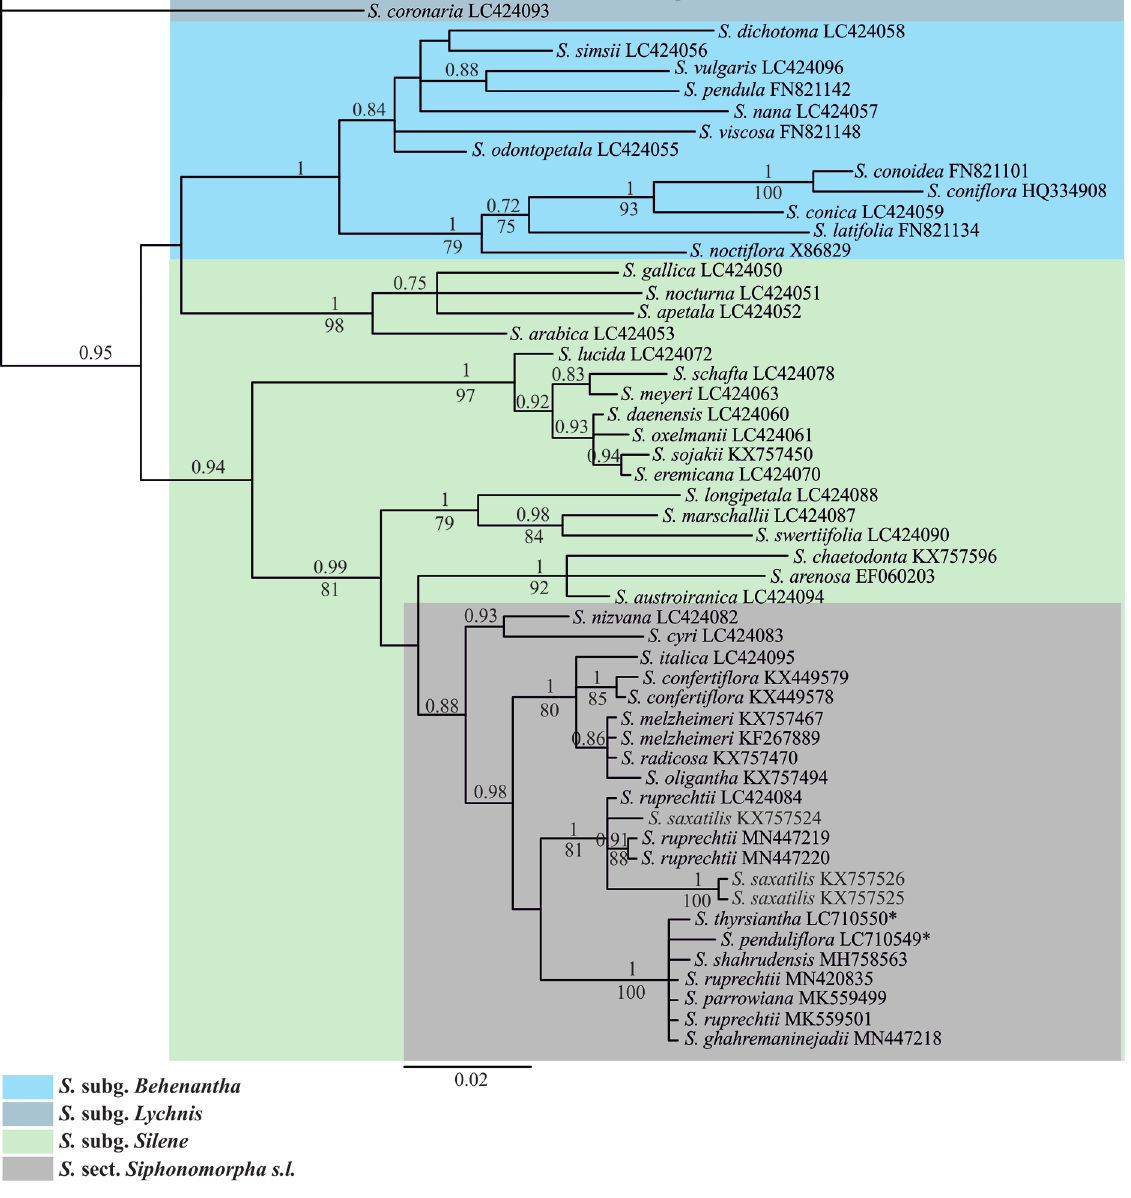
Fig. 1. 50% majority-rule consensus tree obtained from the Bayesian inference analysis of the nrDNA ITS sequences in selected species of Silene L. Posterior probabilities (PP) ≥ 0.70 are shown above the branches and Maximum likelihood bootstrap (MLB) values ≥ 70% below. Accessions newly sequenced are indicated by a star. Accessions of S. ruprechtii Schischk. (MN420835 and MK559501) are misidentified by Bahmani et al.